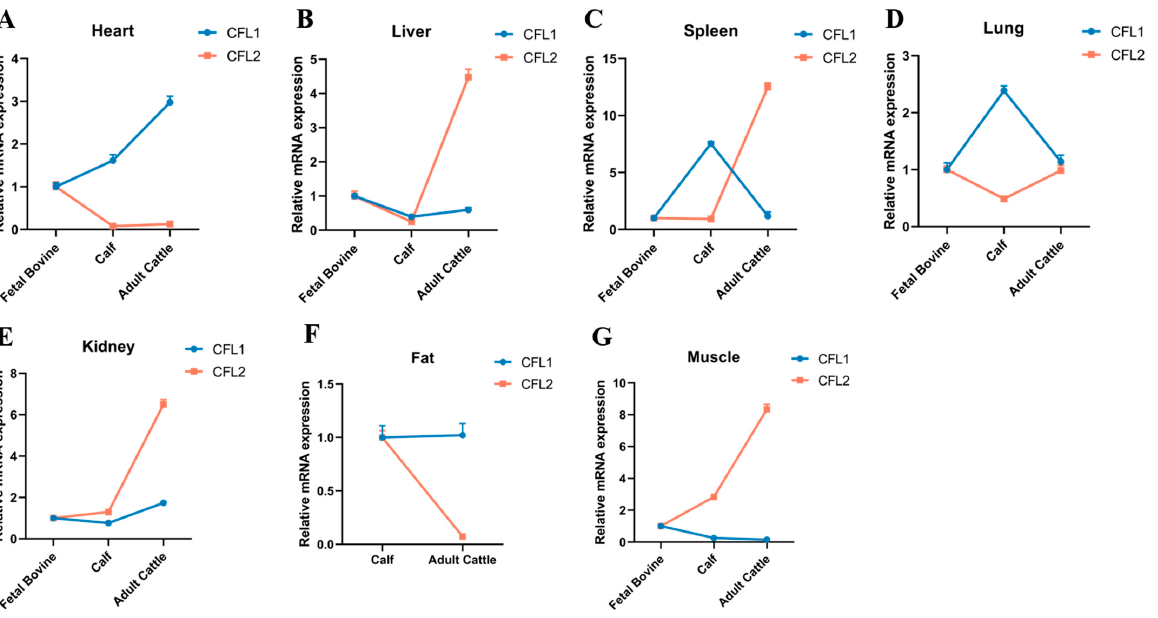
Figure 2. Temporal expression patterns of CFL1 and CFL2 genes in Qinchuan cattle. Expression trends of CFL1 and CFL2 genes in seven tissues ( A – G ). The expression level of all tissues in fetal bovine was considered as 1. The mRNA expression level of CFL1 and CFL2 were normalized to GAPDH. Data are means ± SE of n = 3 independent experiments, each performed in triplicate.